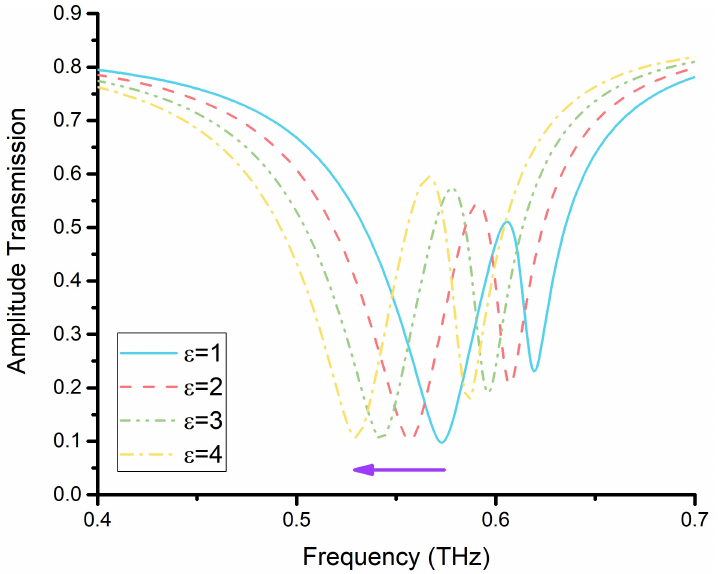
Figure 6. The transmission of CWSRRs with different permittivity values. Taking the permittivity ε = 1 as a reference, the frequency offset value of the two resonance dips with different permittivities is shown in Figure 7. The frequency offset